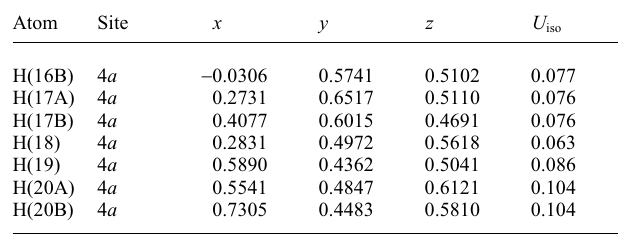
Table 3. Atomic coordinates and displacement parameters (in Å 2 )